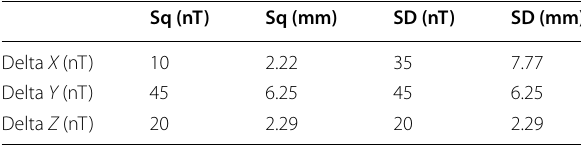
Table 1 Amplitude of the diurnal variation for quiet (Sq) and disturbed (SD) days at Ebro Observatory and their equivalence in displacement on the